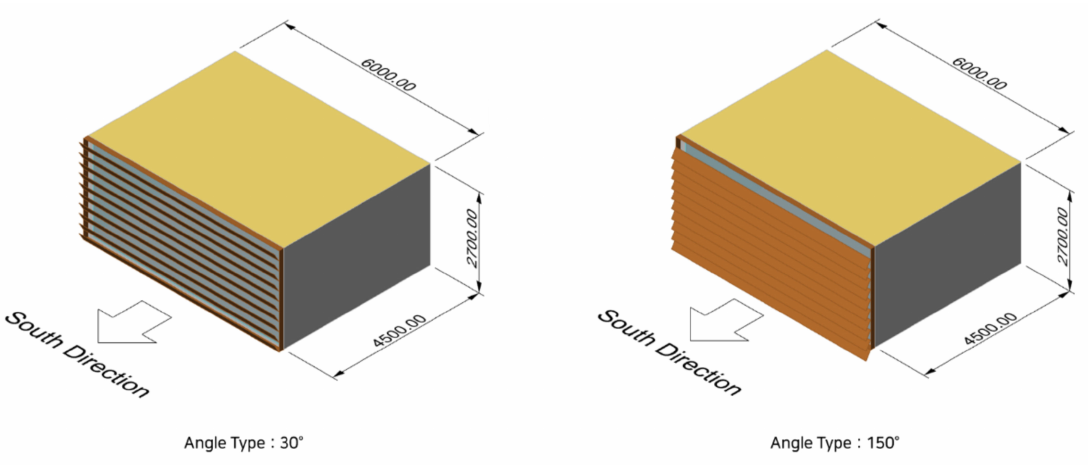
Figure 4. Shape and dimensions of the analysis space.